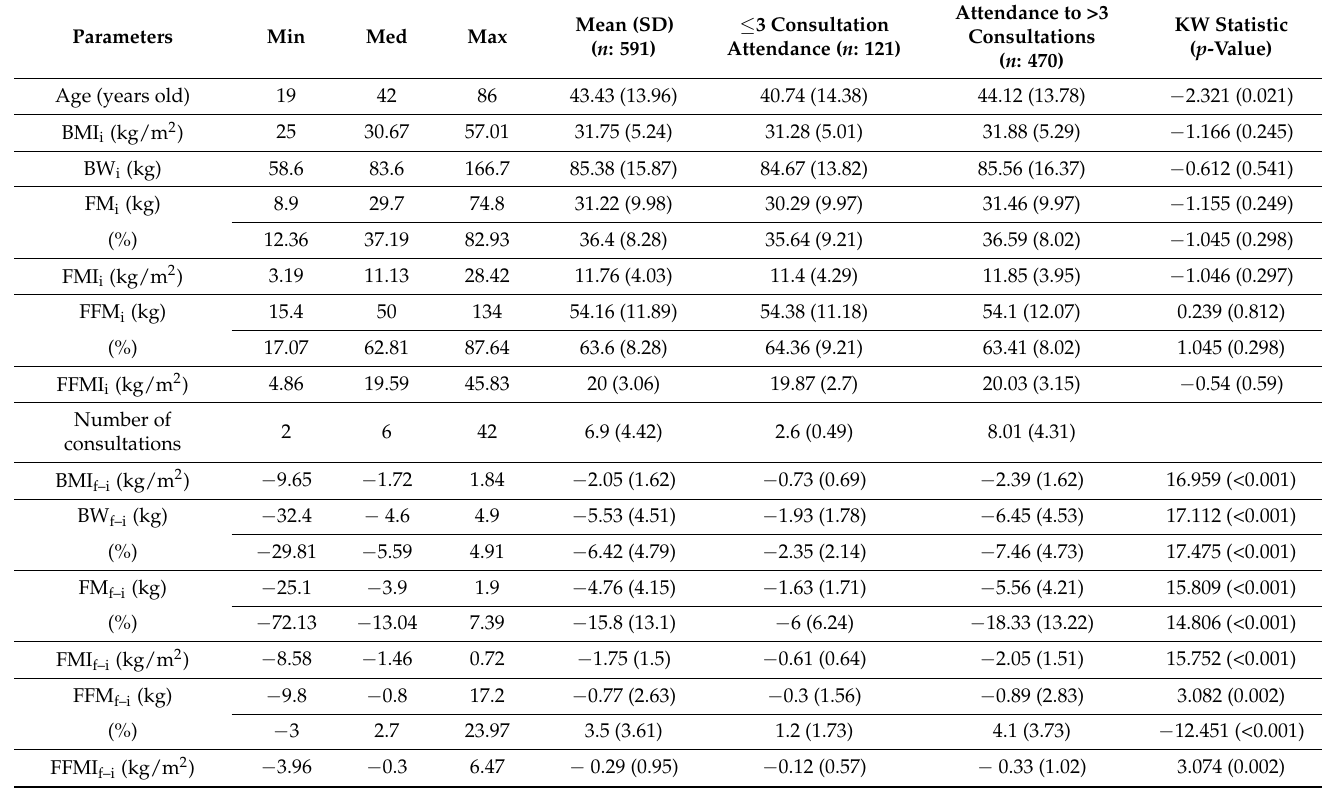
Table 2. Dietary variables based on attendance at the